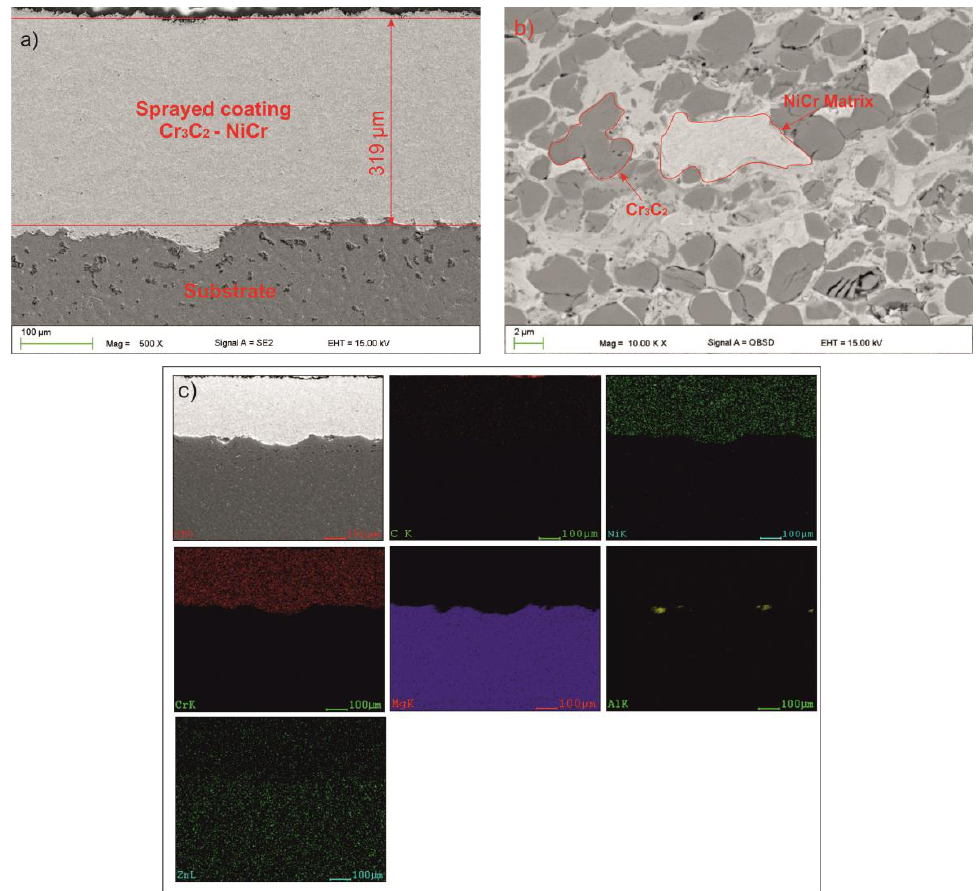
Figure 3. Structure of the coating ( a ) thickness; ( b ) central part of the layer and ( c ) elemental distribution maps of spraying elements in the analyzed area of the coating obtained during thermal spraying.